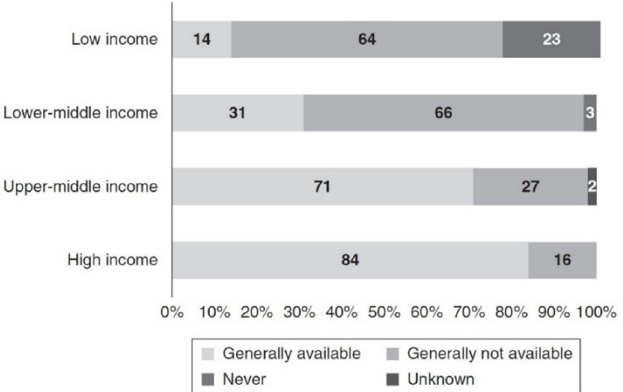
Figure 4. Global availability and capacity of kidney nutrition care. Dietitians/renal dietitians practice settings in outpatient and inpatient settings and nutrition care availability for nondialyzed CKD patients versus those undergoing maintenance dialysis for different World Bank income groups. Used with permission of the American Society of Nephrology, from Assessing Global Kidney Nutrition Care, Wang, A.Y. et.al., 17, 2022 of copyright [119] .